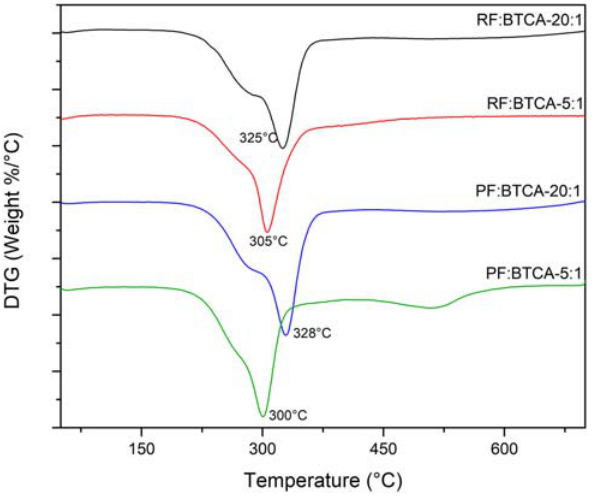
Figure 5: DTG curves of crosslinked fi